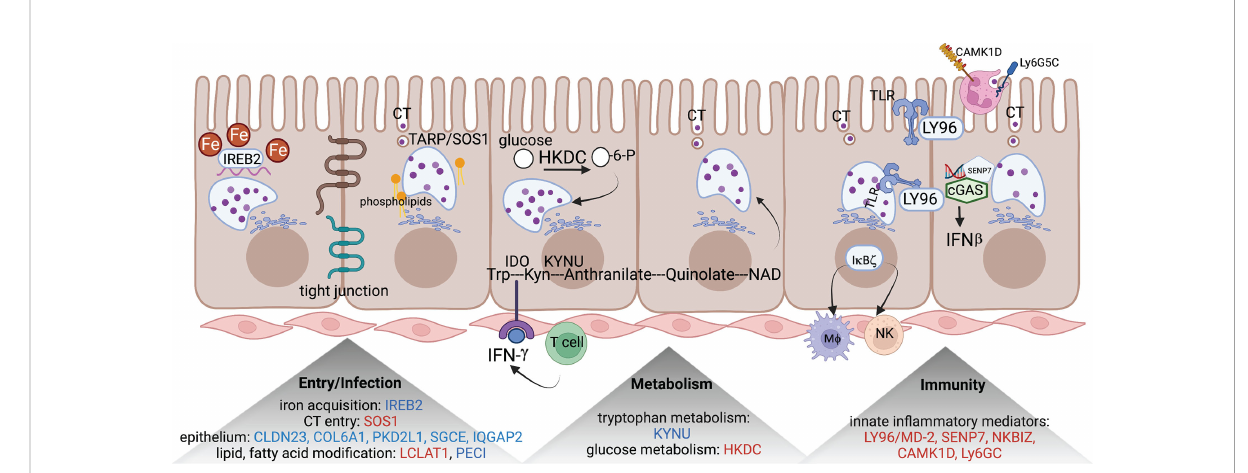
FIGURE 2 eGenes encoding proteins linked to biologic pathways involved in chlamydial infection. eGenes downregulated in women with endometrial infection are listed in blue and include: IREB2, an iron acquisition protein; multiple molecules involved in formation of tight junctions and epithelial integrity (CLDN23, COL6A1, PKD2L1, SGCE, and IQGAP2); PECI, that modi fi es fatty acids; and KYNU, important in tryptophan metabolism. eGenes upregulated in women with endometrial infection are listed in red and include SOS1, that encodes a protein that directly interacts with chlamydial TARP to facilitate entry; LCAT1 important for lipid modi fi cation; HKDC, glucose metabolism; and genes for multiple innate in fl ammatory mediators (LY96/MD-2, SENP7, NKBIZ, CAMK1D, and Ly6GC). The fi gure was created using BioRender.com.